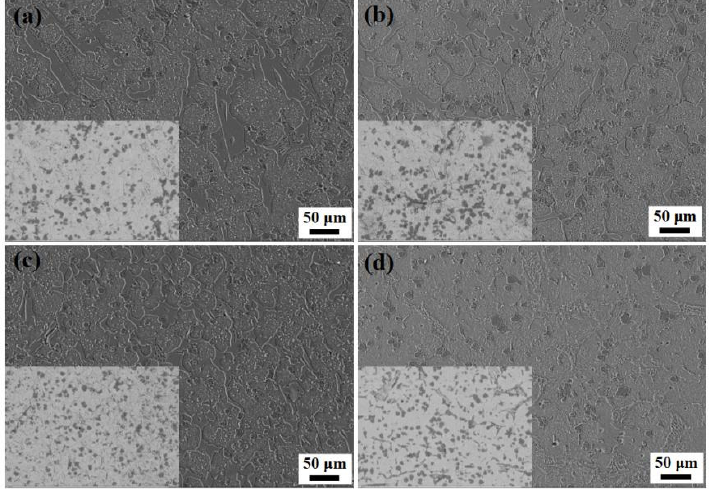
Figure 1. Secondary electron images andbBackscattered electron images of the VCFC with differ- ent heat-treated processes. ( a ) QP, ( b ) QPT, ( c ) MQP, ( d ) MQPT.